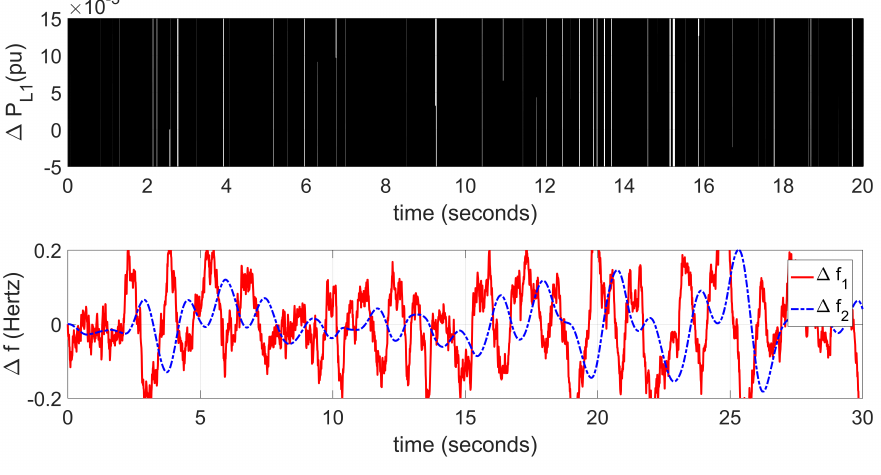
Figure 12. Frequency measurement under load attack ∆ P L